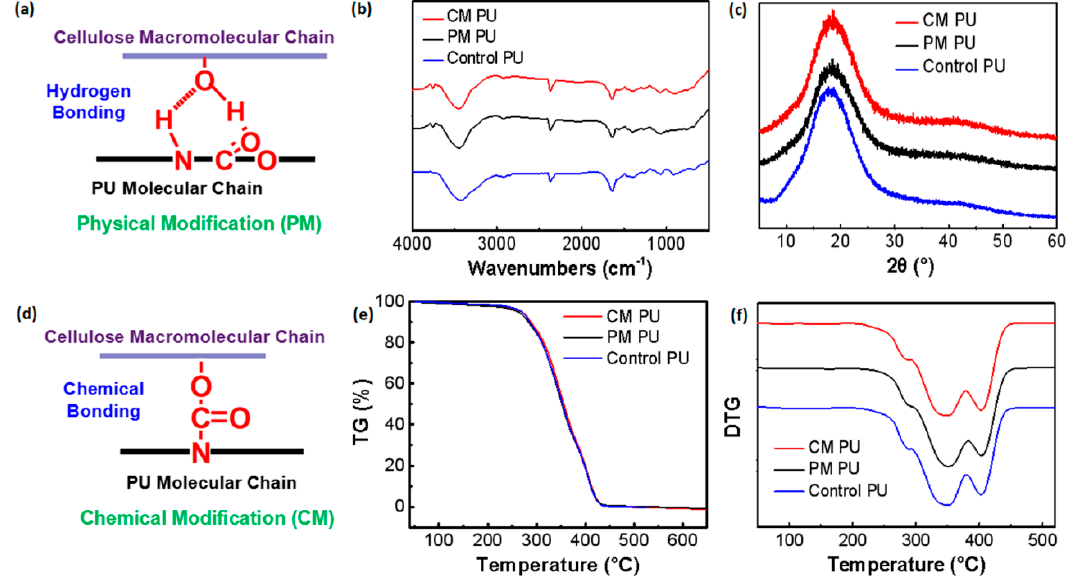
Figure 6. Comparison of the compositions and thermal stabilities of the PU coatings with/without modification. ( a ) Schematic diagram of the hydrogen bond formed between nanocellulose (0.1wt%) and the PU macromolecular chains by physical blending method; ( b ) Comparison of the FTIR curves of the two modified PU films (0.1 wt% nanocellulose addition) and the control PU film; ( c ) Comparison of the X-ray diffraction (XRD) curves of the two modified paint films (0.1 wt% nanocellulose addition) and the control PU film; ( d ) Schematic diagram of the chemical bond formed between nanocellulose and the PU molecular chains under chemical modification method; ( e ) Comparison of the thermogravimetric (TG) curves of the two modified paint films (0.1 wt% nanocellulose addition) and the control PU film; ( f ) Comparison of the DTG curves of the two modified paint films (0.1 wt% nanocellulose addition) and the control paint film.